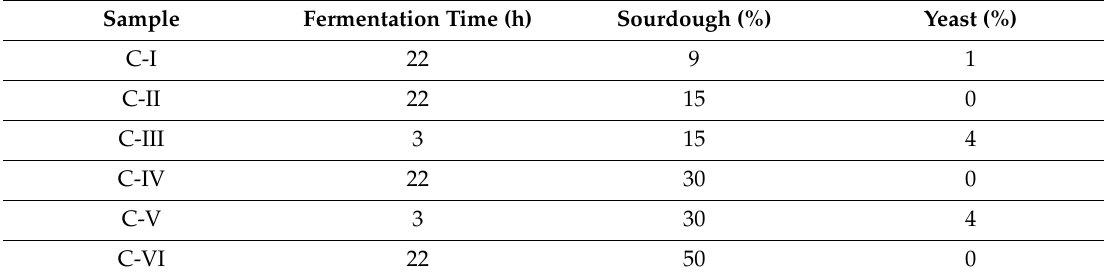
Table 2. Analyzed samples of ciabatta